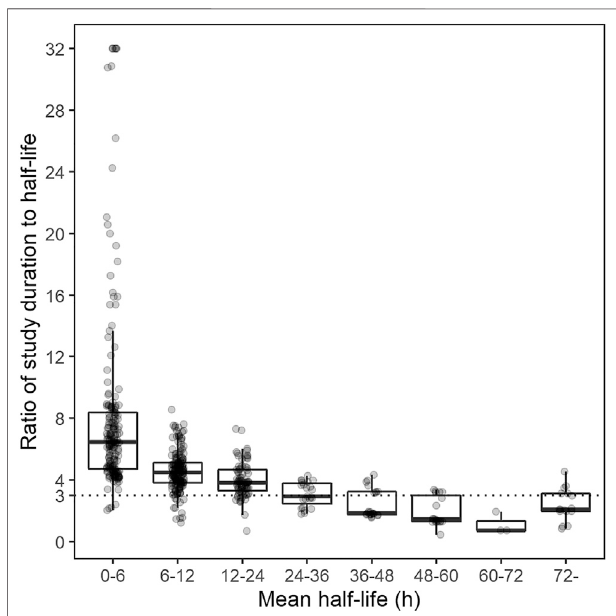
FIGURE 3 | Ratio of study duration to half-life versus grouped half-life. Dotted lines represent recommended minimum ratio of study duration to half-life inSouth Korea. (Note: Ratios > 32were reducedto 32 for visualization. For fi xed dose combination, drug with the highest maximum coef fi cient of variation was selected.)